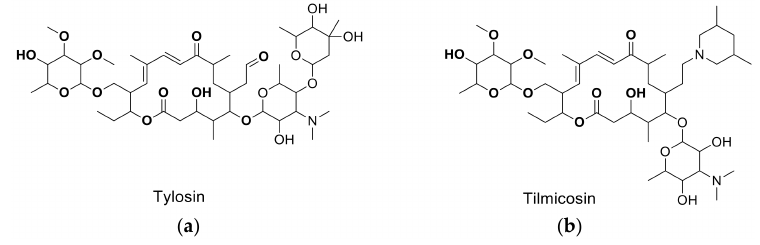
Figure 1. The structures of the molecules: ( a ) tylosin; ( b ) tilmicosin.